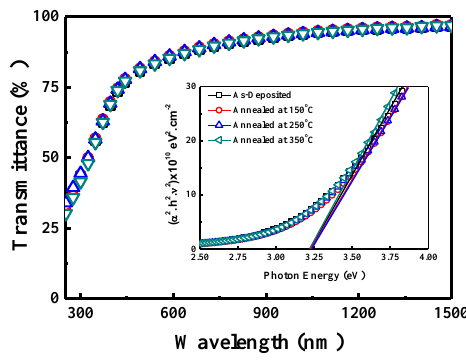
Figure 2. Optical properties of IZTO films deposited at room temperature onto glass substrates at various annealing temperatures in the range of 150–350 °C.